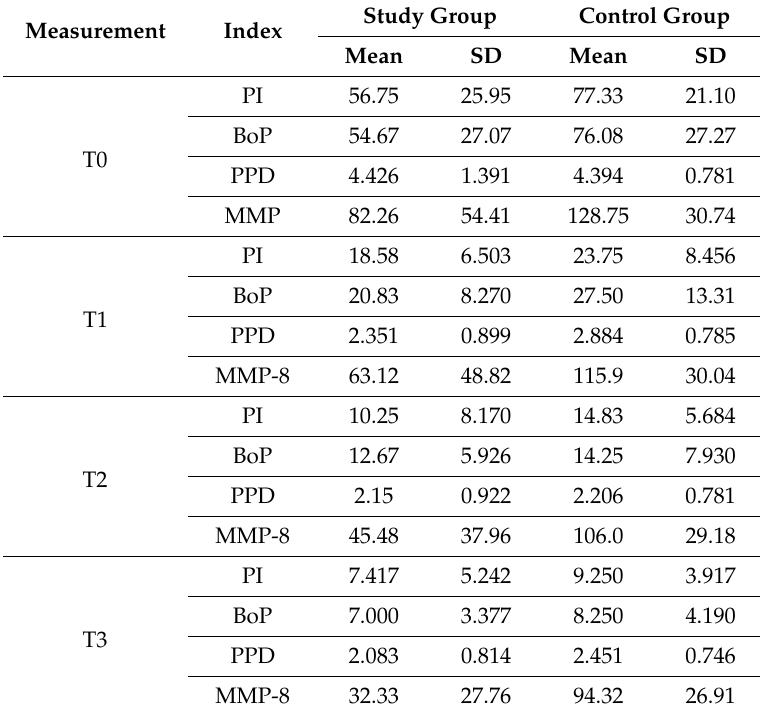
Figure 1. Changes in the distribution of periodontal indices ( a – c ) and salivary metalloproteinase (MMP-8) levels ( d ). Table 1. Descriptive statistics in the study and control group.